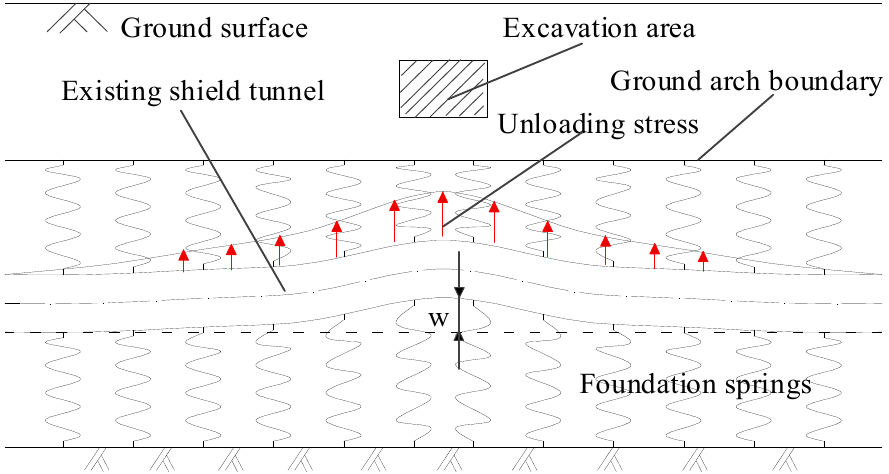
Figure 2. Double-sided elastic foundation beam model for deep tunnel.